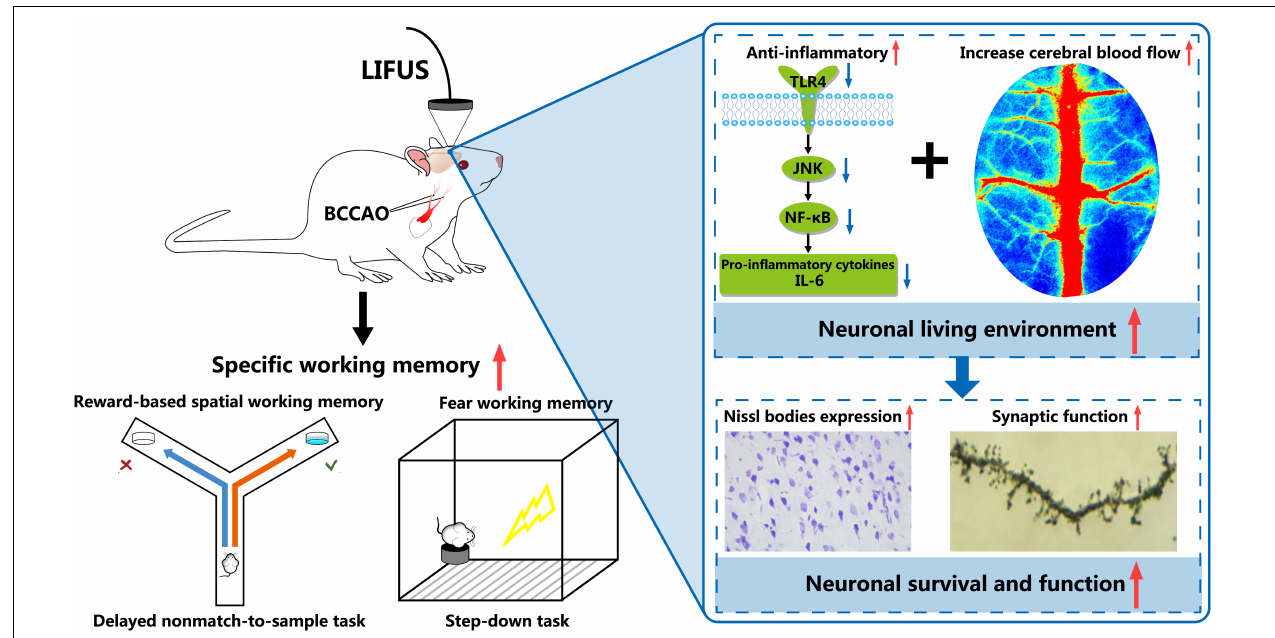
FIGURE 8 | Schematic diagram of the potential mechanism involved in LIFUS treating the working memory disorders induced by VD.